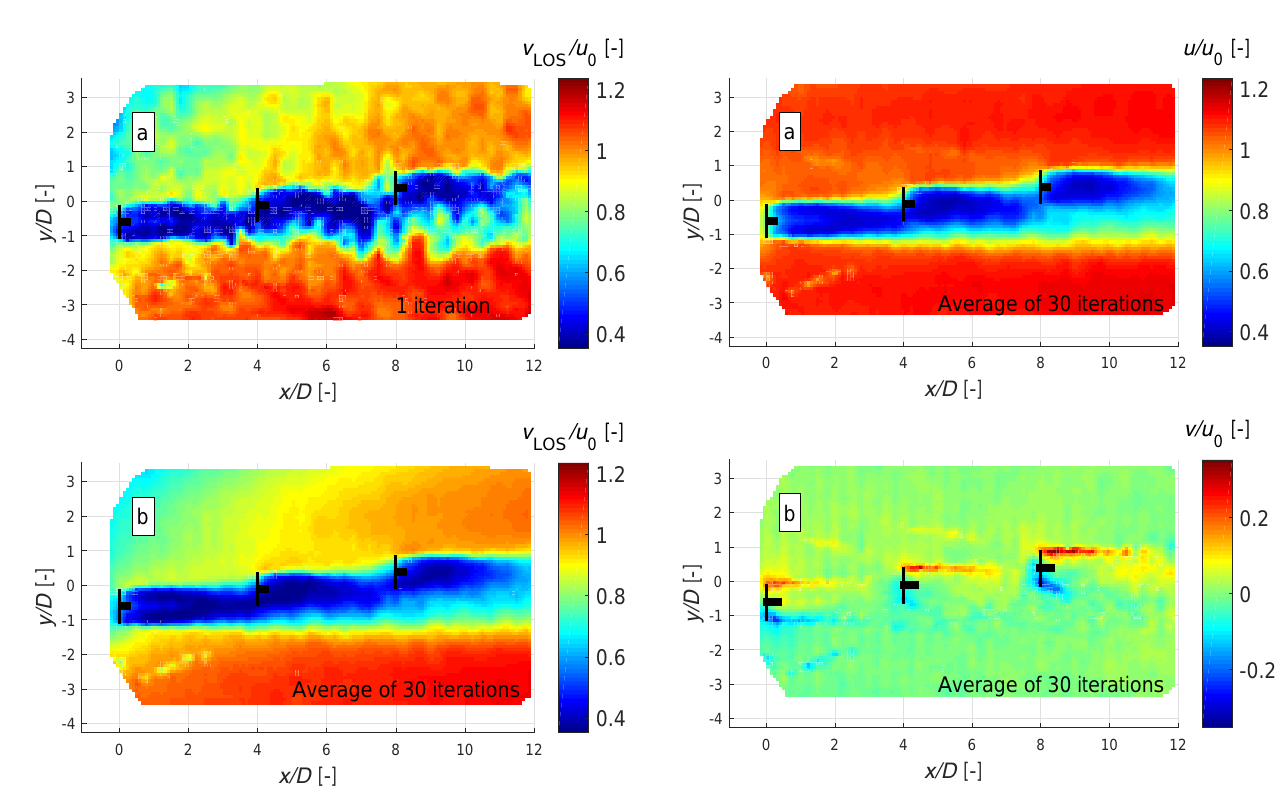
Figure 24. Wake wind field expressed in the evaluated u (a) and v (b)